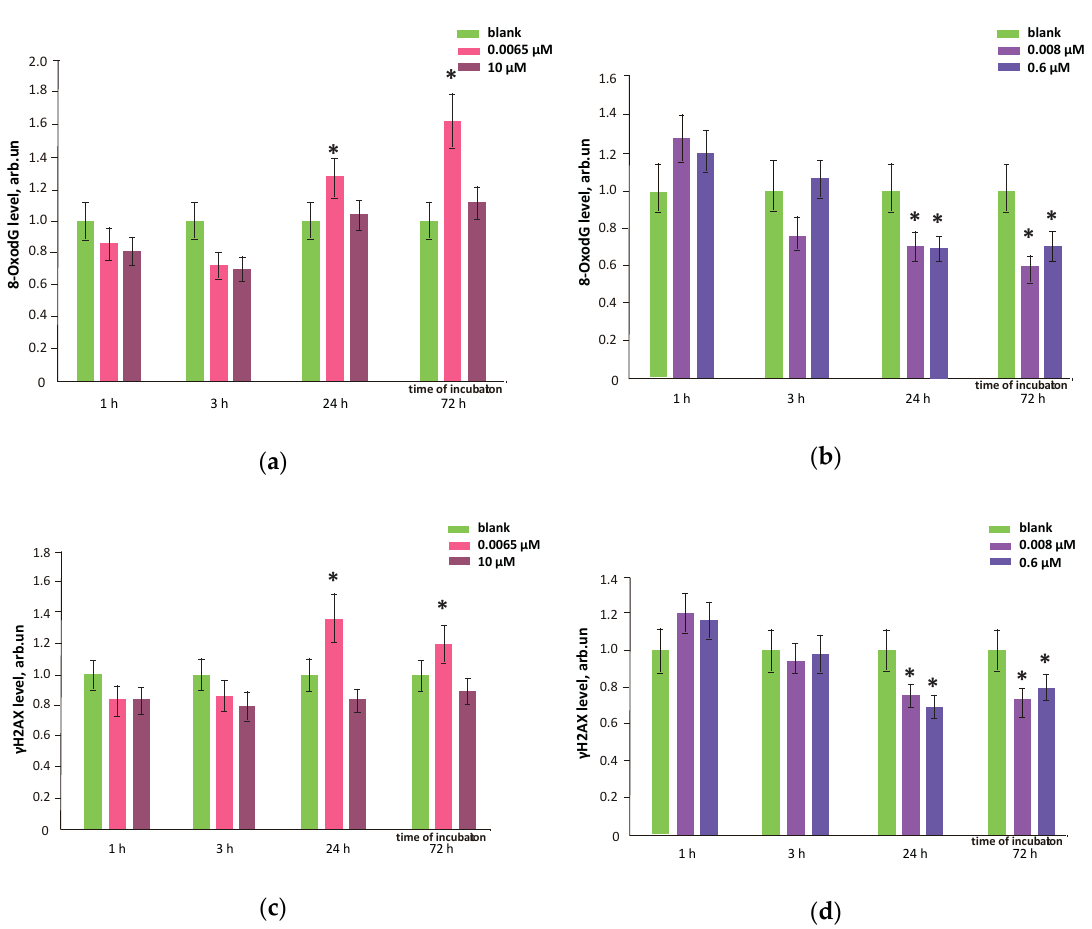
Figure 12. Mean values of 8-hydroxy-2’-deoxyguanosine, the marker of DNA oxidative damage and phosphorylated histone H2AX during incubation of HFLF with fullerenes ( a , c ) FF1 and ( b , d ) FF2 (concentrations are shown in figure). (*) marks the data significantly different from the blank (no fullerenes were added to the cells) according to the Mann–Whitney test. In blank experiments, cells were incubated without the fullerenes.